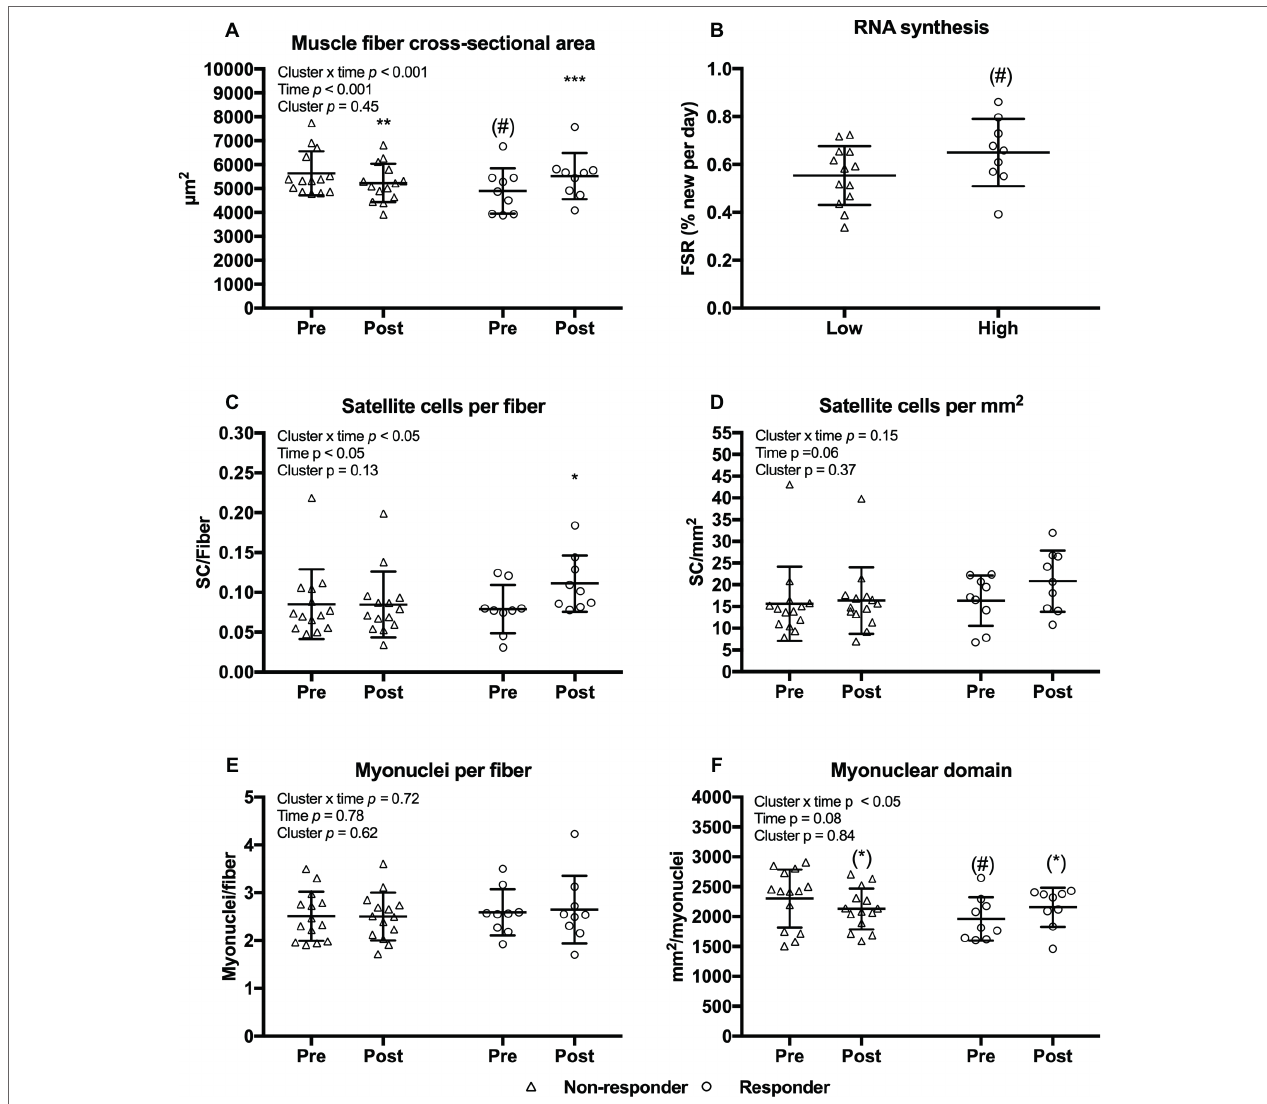
FIGURE 9 | Muscle fiber cross-sectional area (A) , satellite cells per fiber (C) , satellite cells per mm 2 (D) , myonuclei per fiber (E) , and myonuclear domain (F) at baseline (pre) and 4 days after cessation of training (post) in non-responders ( n = 14) and responders ( n = 9) with regards to muscle fiber hypertrophy. RNA synthesis in non-responders and responders (B) . Data are presented as individual values as well as mean ± SD. Overall effects are given in the upper left corner of graphs. (*) p < 0.1 tendency toward difference from pre within cluster. * p < 0.05, ** p < 0.01, and *** p < 0.001 different from pre within cluster; (#) p < 0.1 tendency toward difference to non-responders within